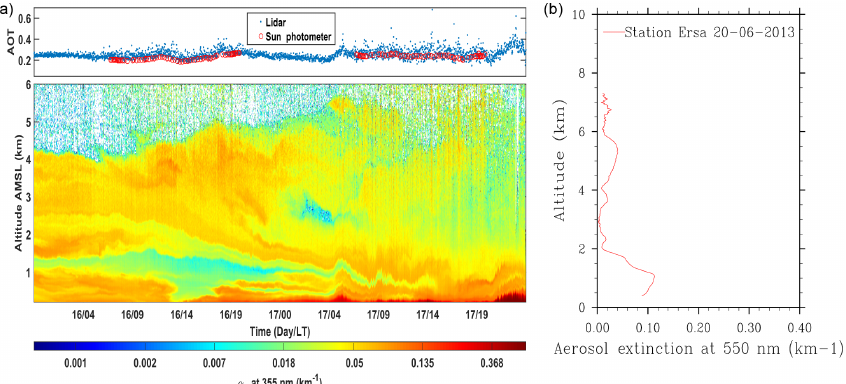
Figure 22. Minorca (a) and Ersa (b) lidar observations obtained during the dust plume of 16 to 17 June transported over the western Mediterranean